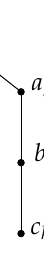
Figure 1. The graph H k ( k ≥ 2 ) which is defined